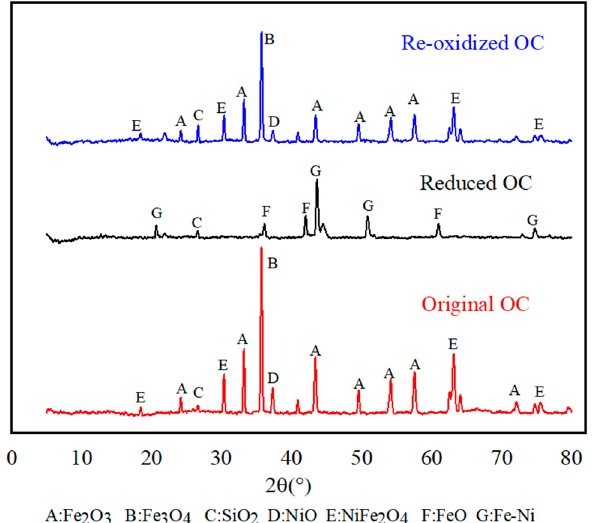
Figure 9. The XRD spectra of the fresh OC (red), the reduced OC (black), and the re-oxidized OC.